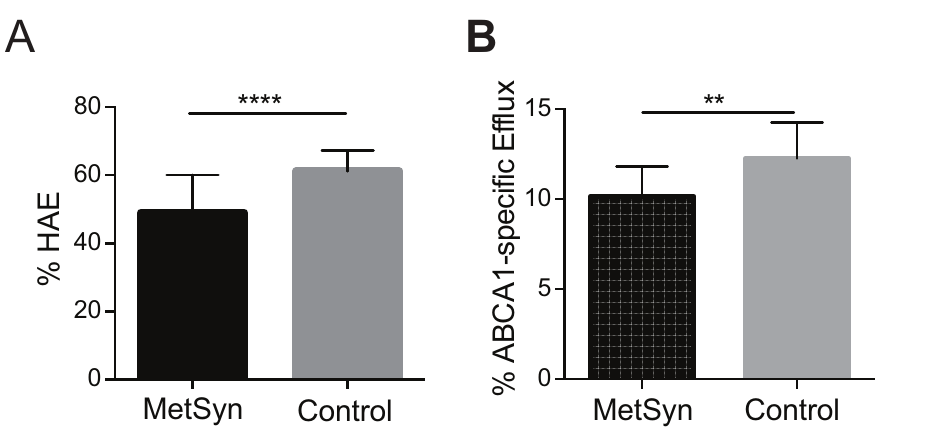
Fig 1. HDL function is impaired in MetSyn patients. ( A ) Average HDL-apoA-I exchange(HAE) and ( B ) ABCA1-specific CEC of MetSyn (n = 60) and healthycontrol (n = 14) subjects. Error bars represent SD. Statistical significancewas determined by performing two-tailed, unpaired t -test with Welch’s correction ( **** P < 0.0001; ** P < 0.01). https://doi.org/10.1371/journal.pone.0182217.g001 group (10.1 ± 1.6% vs. 12.3 ± 2.0%, P = 0.002, Fig 1B ). The inclusion / exclusion of patients